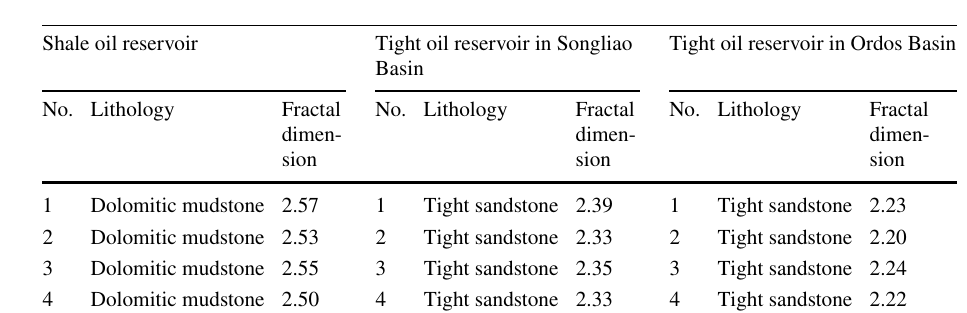
Fig. 9 Fractal features of four cores Table 6 Fractal dimension